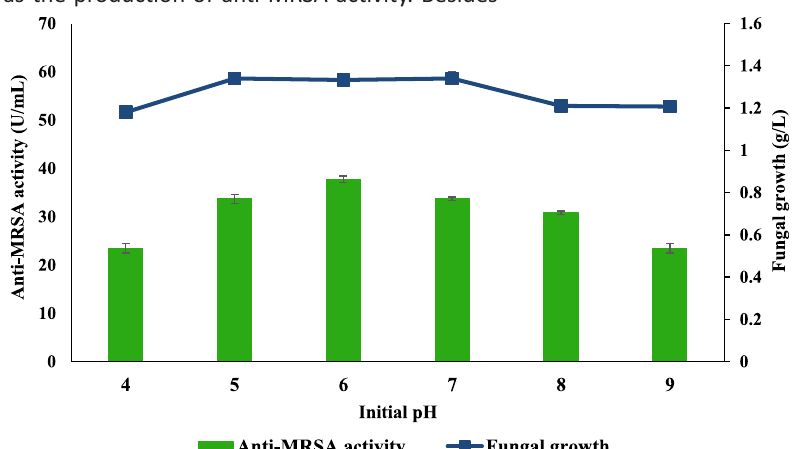
Fig. 4. Effects of initial medium pH on the production of anti-MRSA activity and fungal growth by L. pseudotheobromae IBRL OS-64. Different letters indicate significant differences between means (Duncan, p<0.05). Standard deviation values of triplicate analyses are shown by error bars.